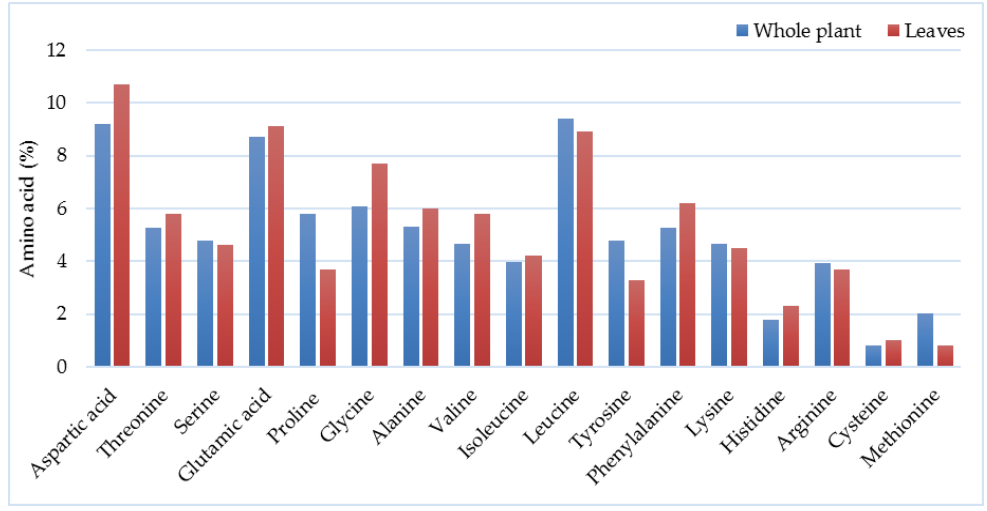
Figure 4. Percentage of amino acids from Silphium perfoliatum , compared to its leaves. Source: References [46,81].